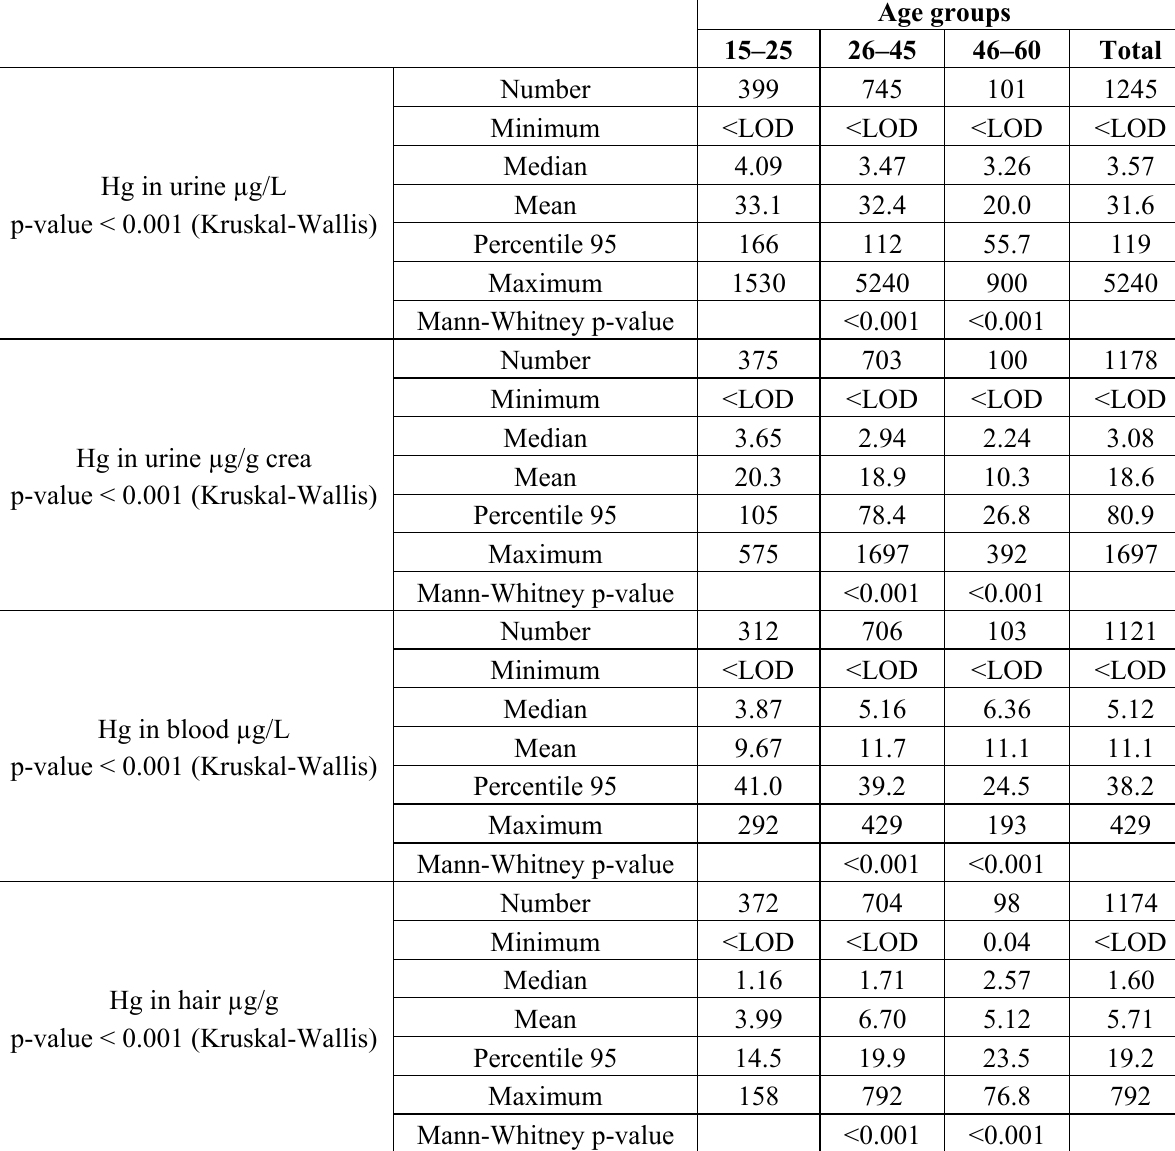
Table 1. Distribution of mercury levels in human specimens for three age